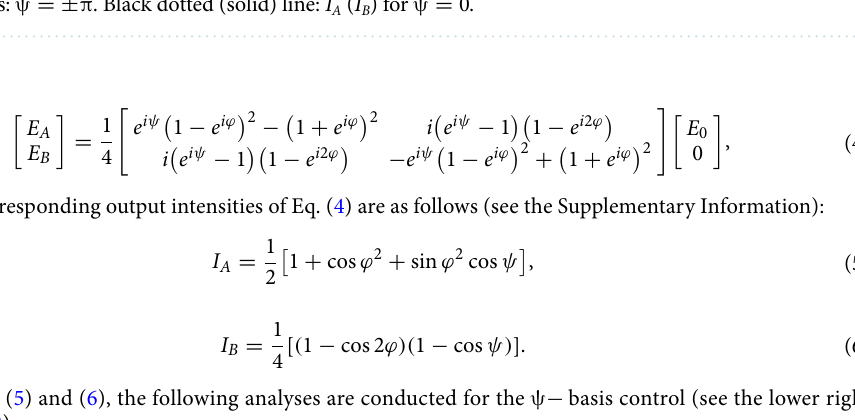
Figure 2. Numerical calculations for Fig. 1. Upper panels: n = 1. Lower panels: n = 2. (third column) Blue dotted and red curves: ψ = ± π . Black dotted (solid) line: I A ( I B ) for ψ = 0